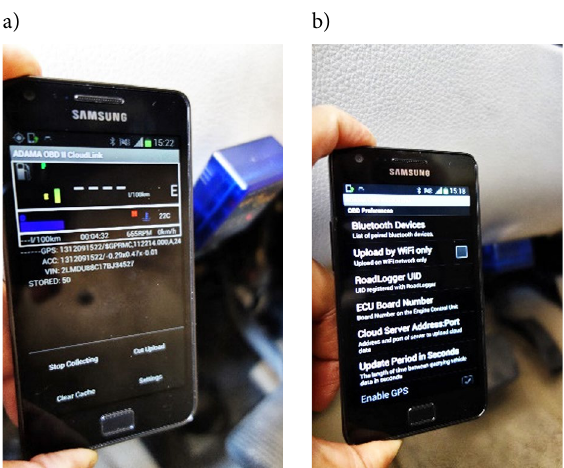
Fig. 4. User interface of the mobile application on a Galaxy S2 smartphone: a – dashboard screen; b –